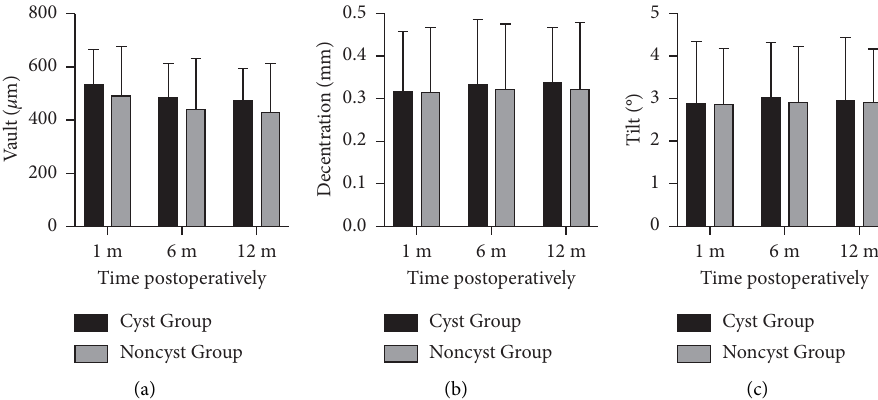
Figure 4: Mean vault (a), decentration (b), and tilt (c) of the cyst group and the noncyst group at each follow-up at diferent time points. ∗ P < 0 . 05, the error bar indicates the standard